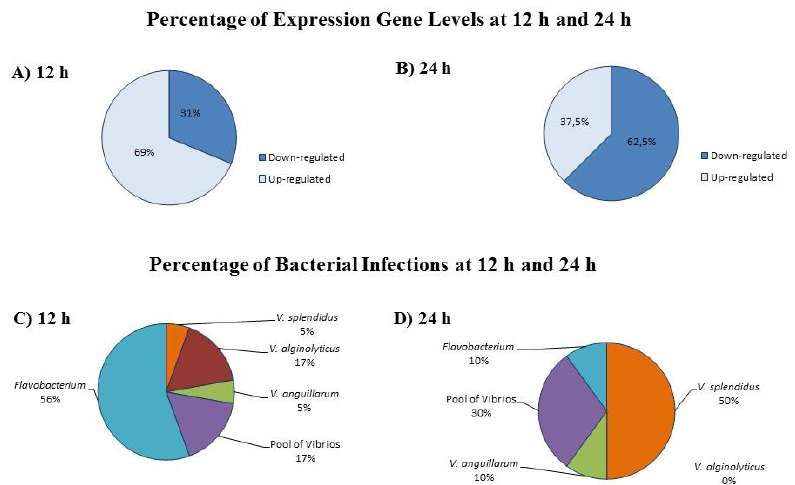
Fig. 8. Percentage of gene expression levels and percentage of genes induced by bacterial infections at 12h and 24h infection time based on qPCR results. (A) and (B) Percentage of down- and up-regulated genes at 12h and 24h respectively. (C) and (D) Percentage of genes induced by bacterial infections ( V. splendidus , V. alginolyticus , V. anguillarum , pool of Vibrios and Flavobacterium ) based on percentage of up-regulated genes in B. azoricus. Fig. 8 Table 3. Mascot search results of B. azoricus peptides that match with sequence of Accession Nr., Mass, Score and Description that was based on probability Mowse